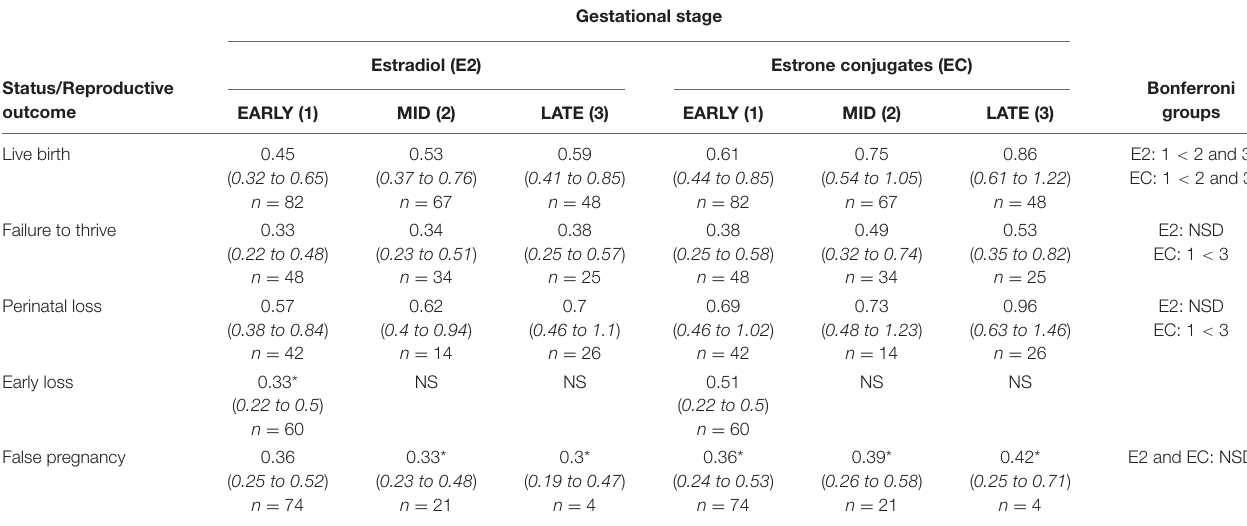
TABLE 5 | Marginal mean ( 95% CI ) estradiol and estrone conjugate concentrations (ng/ml) during each stage of normal (live birth) and abnormal bottlenose dolphin pregnancies.